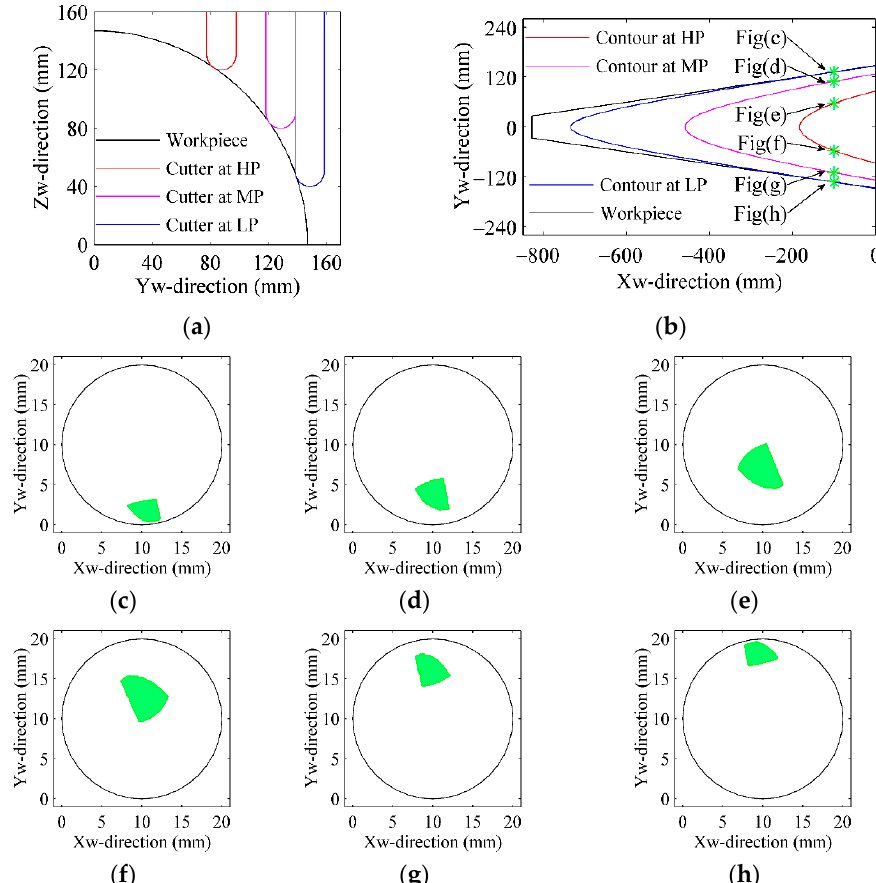
Figure 4. Schematic diagrams: ( a ) cutter–workpiece engagements in the view of the X w ‐ direction; ( b ) different contour tool paths in the view of the Z w ‐ direction and distribution of the chosen positions; ( c – h ) simulation results of the cutter–workpiece engagements from the chosen positions.